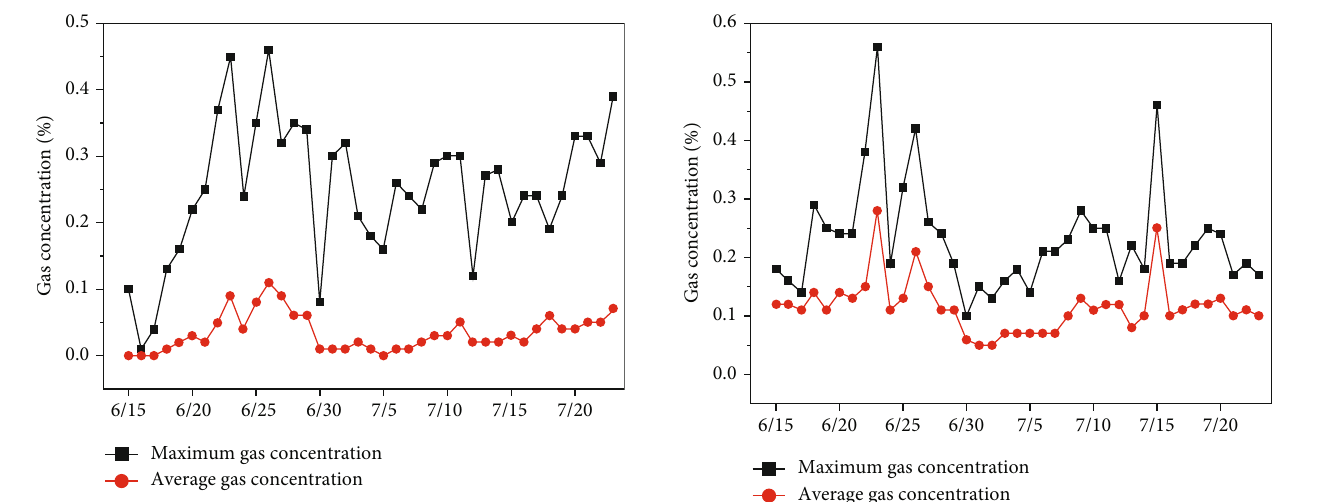
Figure 14: Curve of gas concentration in working face.